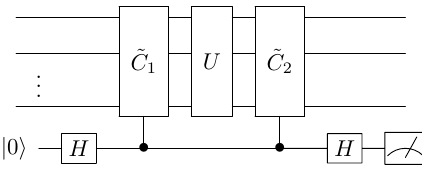
Figure 1. Overview of the one-layer version of the PCS scheme. U represents the gates of the computation and acts across n compute qubits. U is sandwiched between two controlled unitaries comprising ˜ C 1 and ˜ C 2 that satisfy Eq. (11). The ancilla is the bottom qubit. The measurement is performed in the measurement outcome one is discarded, and zero is